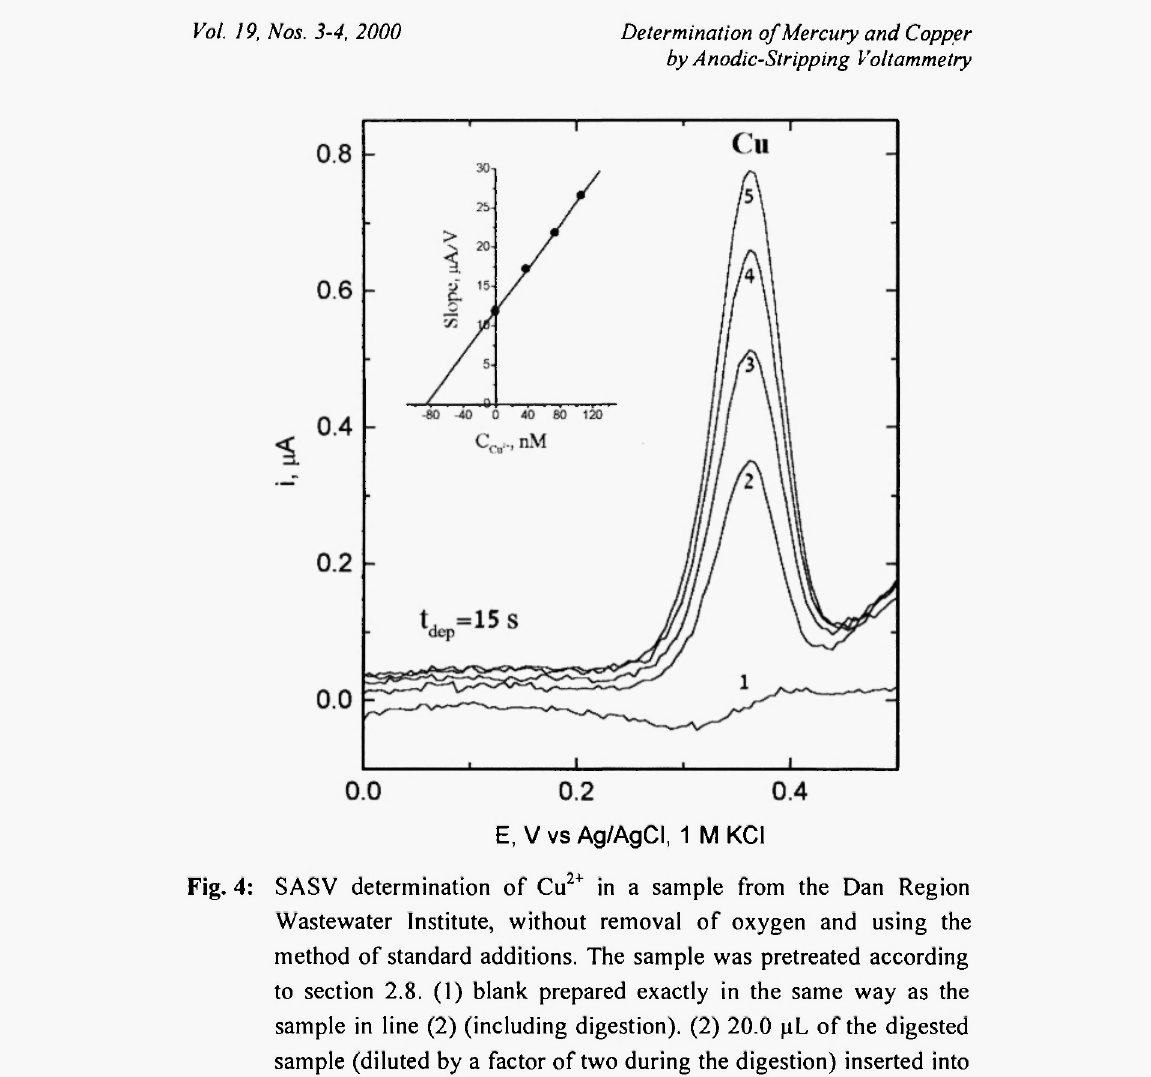
Fig. 4: SASV determination of Cu 2+ in a sample from the Dan Region Wastewater Institute, without removal of oxygen and using the method of standard additions. The sample was pretreated according to section 2.8. (1) blank prepared exactly in the same way as the sample in line (2) (including digestion). (2) 20.0 μί of the digested sample (diluted by a factor of two during the digestion) inserted into 5.00 mL supporting electrolyte (10 mM NaCl, 10 mM HN03). (3), (4) and (5) standard additions of 200 μ ι, 1.00 μΜ Cu 2+ . E dep = -.4 V; t dcp = 15 s; All other conditions as in Fig.